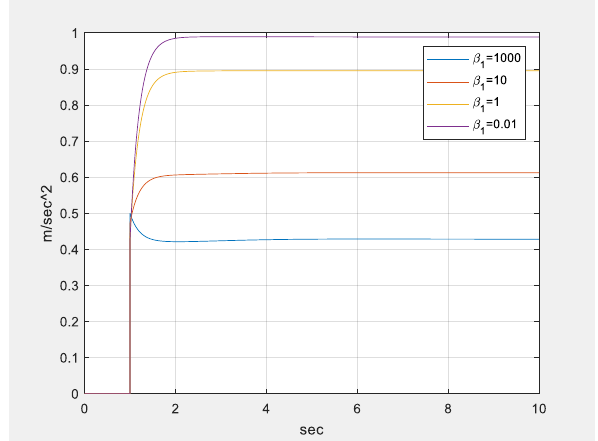
f , generated by the simulator. sx